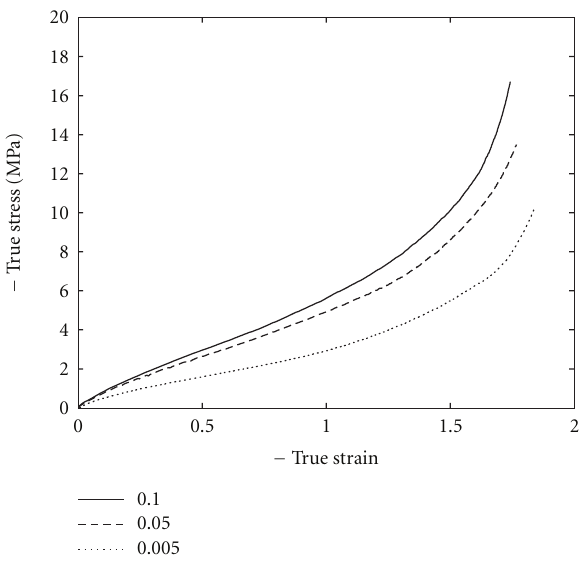
Figure 4: Material comparison, plane strain compression at 90 ◦ C and